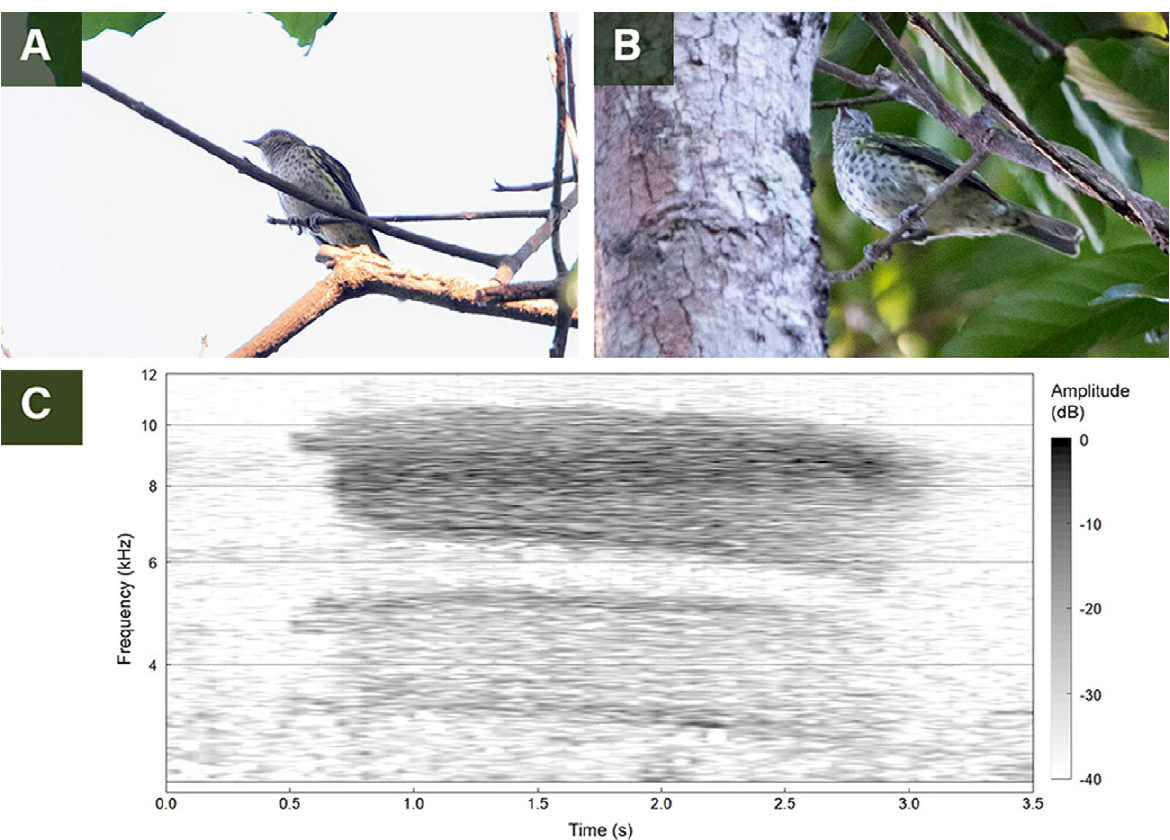
Figure 2. A, B. Oxyruncus cristatus photographed at Fazenda Boa Esperança, Municipality of Cidelândia, Maranhão, Brazil. C. Spectrogram of the vocalization of the individual recorded in this